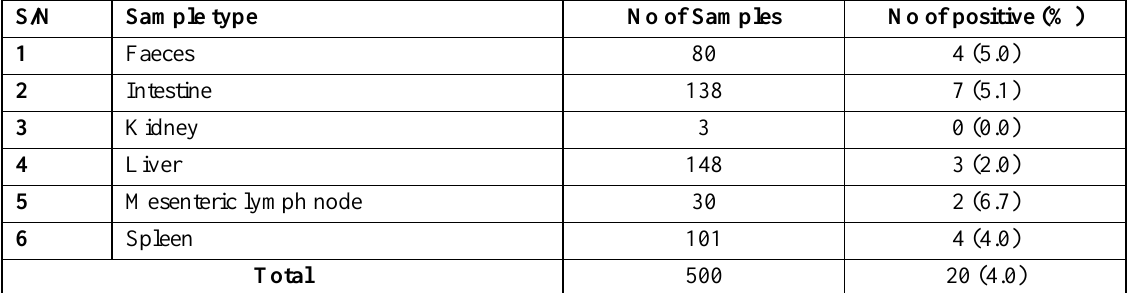
Table 2. Organ distribution of Salmonella species isolated from ruminant slaughtered at the two major abattoirs in Ilorin, Kwara State.